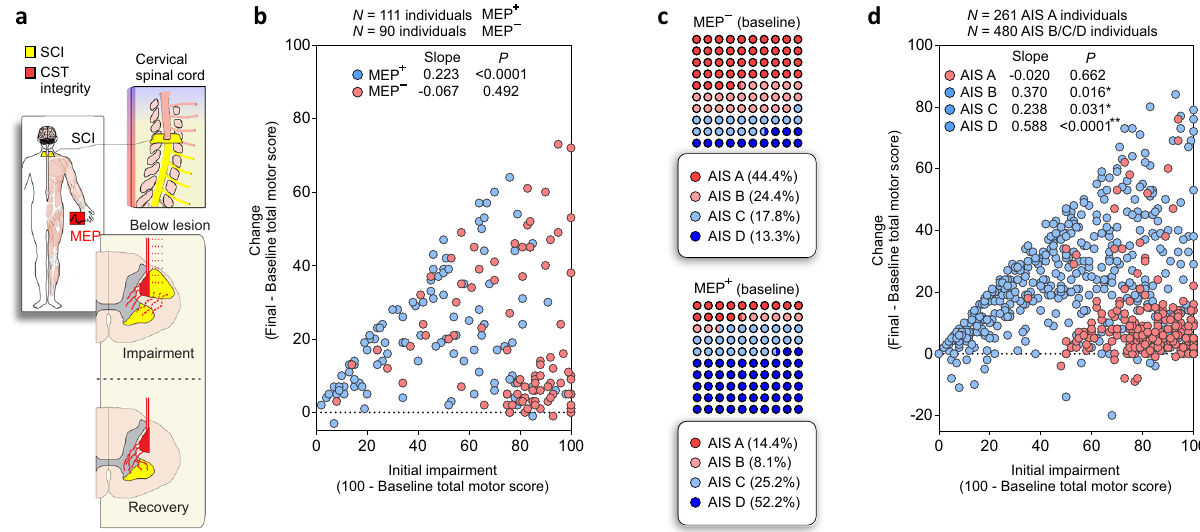
Fig. 8 | CST and LMN integrity (as assessed by MEP) indicates impairment and recovery after SCI: individuals classi fi ed as AIS A and impaired spinal cord function(CSTandLMNintegrity)displaylimitedmotorrecovery.a CervicalSCI (yellow)maydamagespinalcordstructuresandaffectthespinalcordfunctionality below the level of injury with respective weakness of the innervated muscles. Volitionalstrengthandstrengthrecoveryaredependentontheresidualspinalcord function(red),herequanti fi edbytheresidualmusclestrengthandMEPamplitude. b Individuals with absent MEP (MEP − ) display greater damage to the descending pathway (evidenced by the greater initial impairment) and limited recovery of motor function of the spinal cord ( p =0.492). The presence of an MEP (MEP + ) indicates variable levels of spinal cord or LMN damage and recovery ( p <0.0001). c Individuals with an MEP − at baseline were predominantly classi fi ed as AIS A, and individuals with an MEP + predominantly classi fi ed as AIS D. d Strength recovery